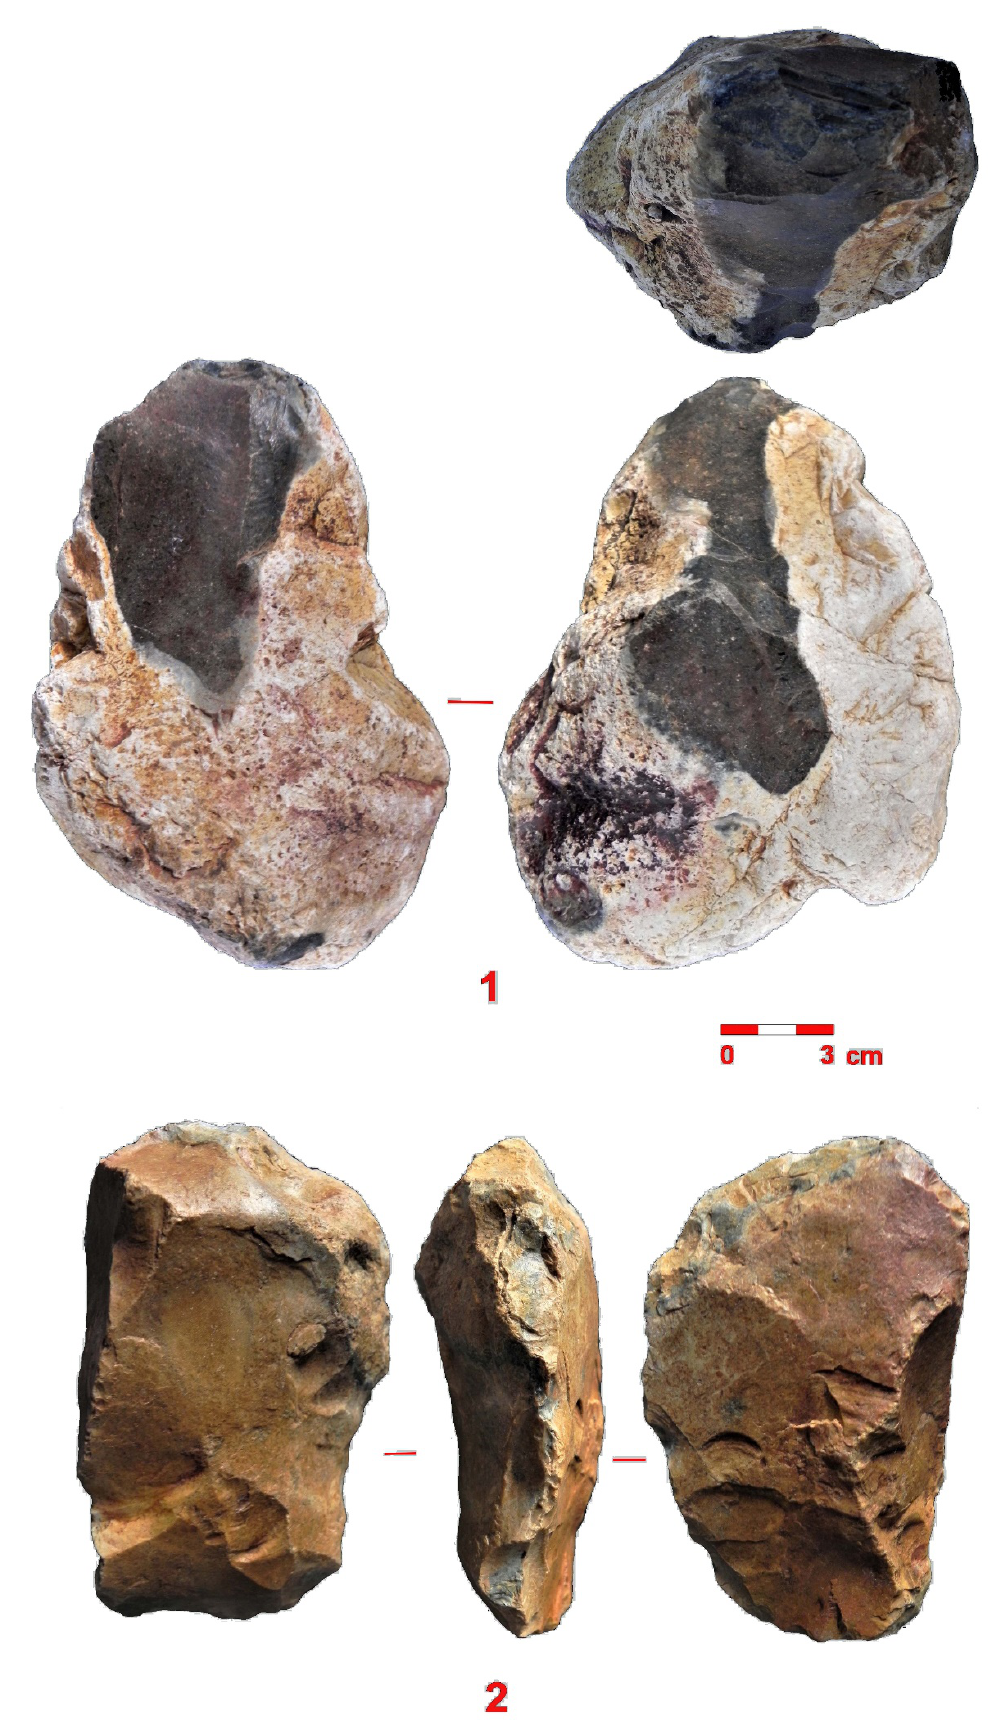
Figure 3. A chopper (1) and a cleaver and scraper (2). All artifacts made on